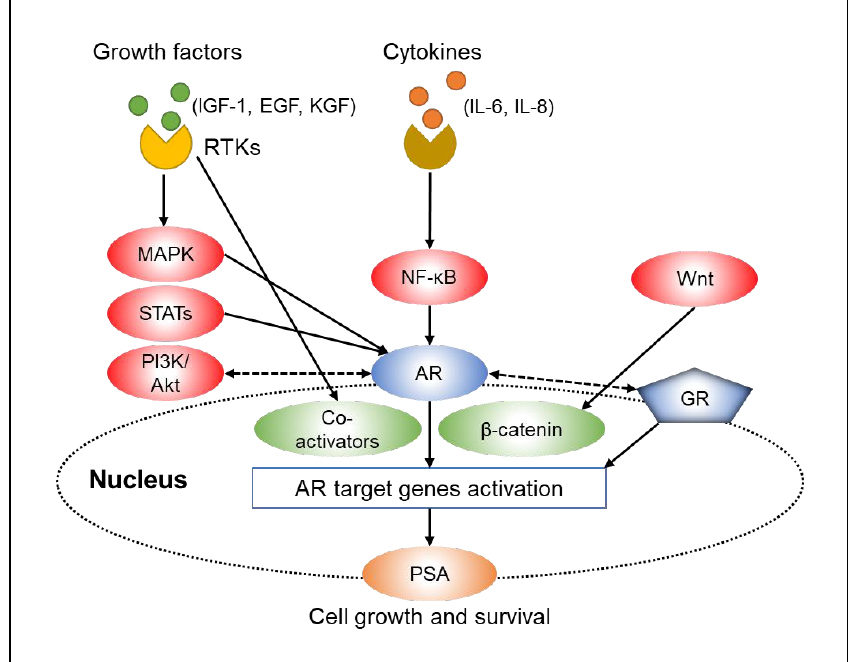
Figure 1. Schematic presentation of the androgen receptor (AR) bypass/crosstalk mechanisms. AR androgen receptor, EGF epidermal growth factor, GR glucocorticoid receptor, IGF-1 insulin-like growth factor-1, IL interleukin, KGF keratinocyte growth factor, PSA prostate-specific antigen, RTK receptor tyrosine kinases. Solid arrows indicate activation and broken arrows indicate interaction.